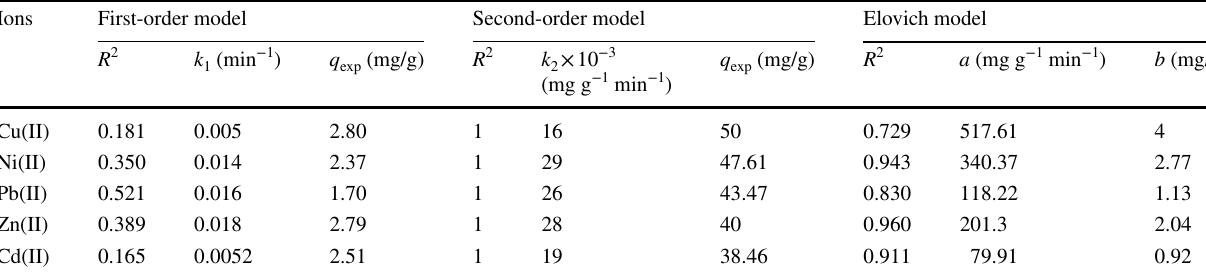
Table 3 Constants of kinetic models during heavy metals biosorption